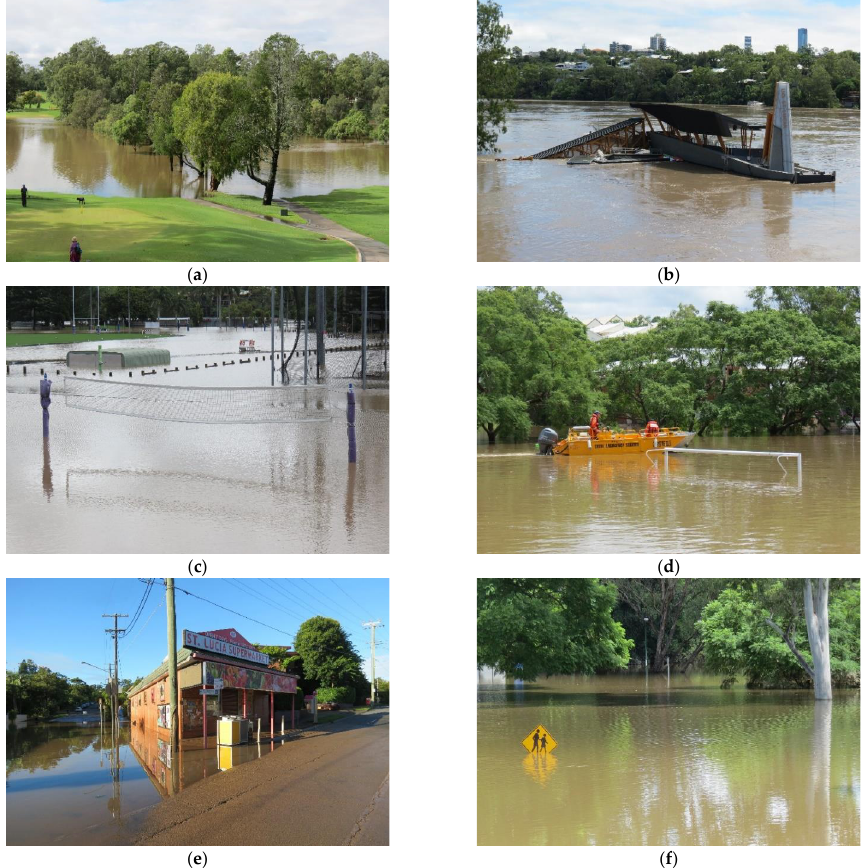
Figure 7. Photos of the flood taken on 28 February 2022 in the suburb of St. Lucia. The locations of the photos are shown in Figure 6. ( a ) The St. Lucia Golf Course; ( b ) The CityCat ferry station of the University of Queensland on the Brisbane River; ( c ) University of Queensland fields (ovals) no. 6 and 7; ( d ) William Dart Park (note the inundated soccer goal); ( e ) St. Lucia Market on Sir Fred Schonell Drive; ( f ) Heroes Avenue between Jack Cook Memorial Park and Perrin Park. The Capella SAR image acquired on 28 February 2022 covered a smaller area than the PlanetScope image; however it did cover significant areas of the Oxley Creek flood plain to allow comparison between the two mapping approaches of inundated areas. Using the Capella image, we identified less inundated areas; however, many inundated areas were clearly omitted in the Capella mapping (Figure 8). The flooding had a clear impact on electricity loads as reported by Energex for SEQ (Figure 9a,b) and on nighttime brightness as measured by VIIRS (Figure 9c,d). Out of 240 substation zones of Energex, in 133 zones (55%), there was a statistically significant decrease in electricity loads on the weekdays between the pre-flood week (21 – 25 February 2022) and flood week (28 February – 4 March 2022). Out of 11,236 lit grid cells within the